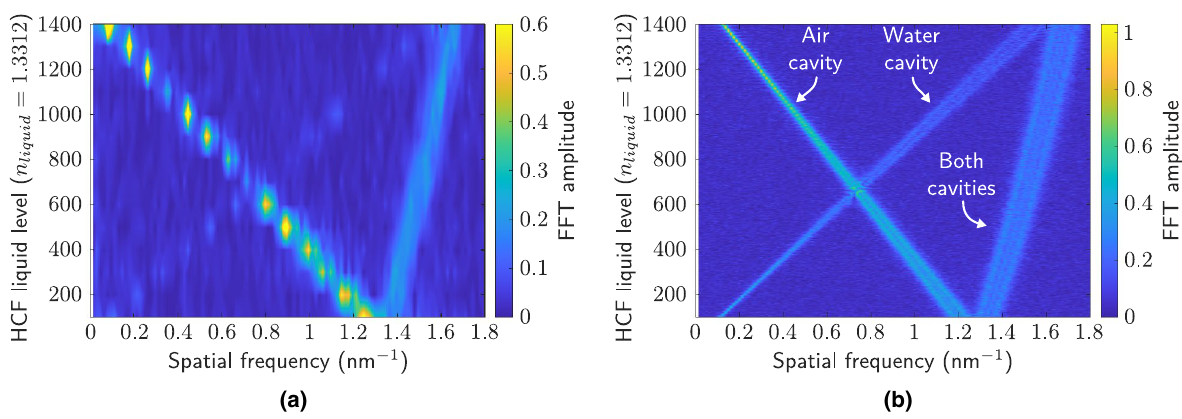
Figure 8. ( a ) Experimental FFT amplitude measured for water levels in the HCF between 100 and 1400 µ m, with a spacing of 100 µ m. ( b ) Simulated FFT amplitude for water levels in the HCF between 100 and 1400 µ m.